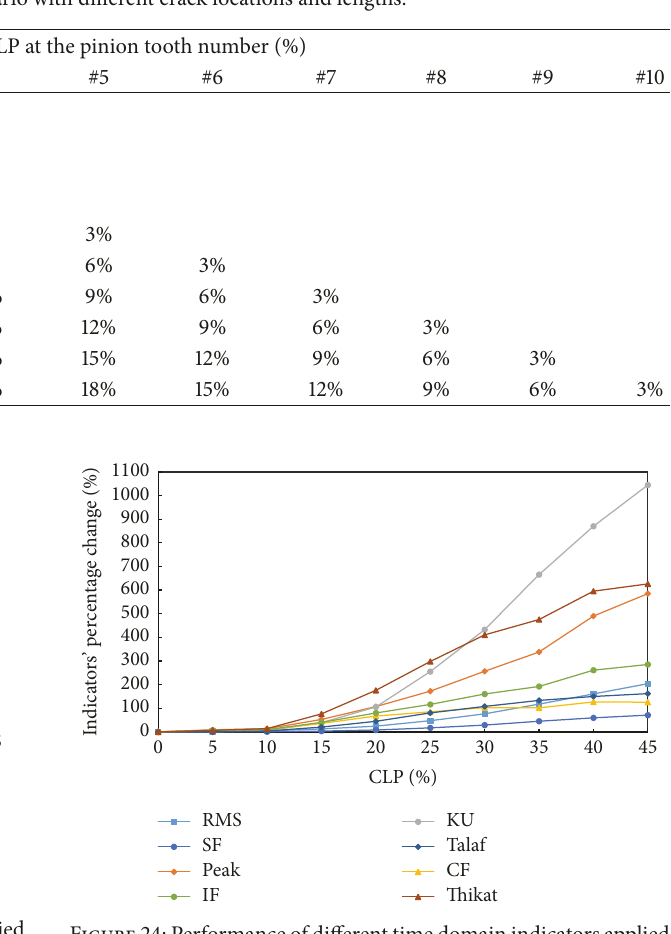
Figure 24: Performance of different time domain indicators applied to the residual